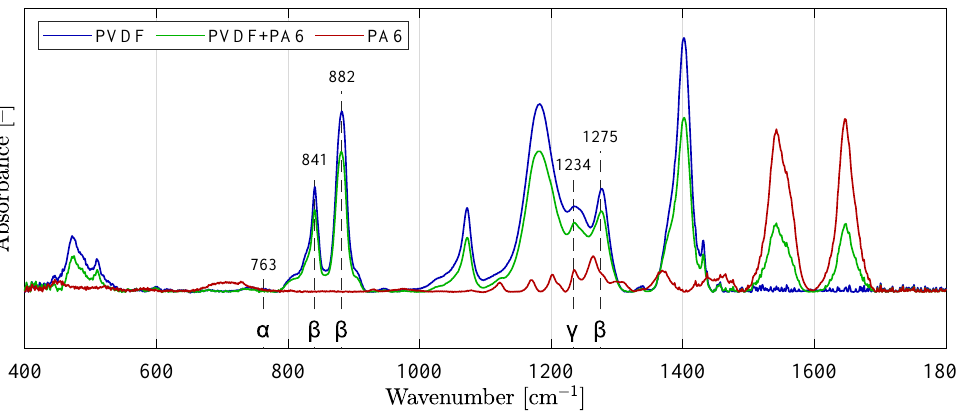
Figure 11. Absorption FT-IR spectra of three overlaid curves with typical and known phases.